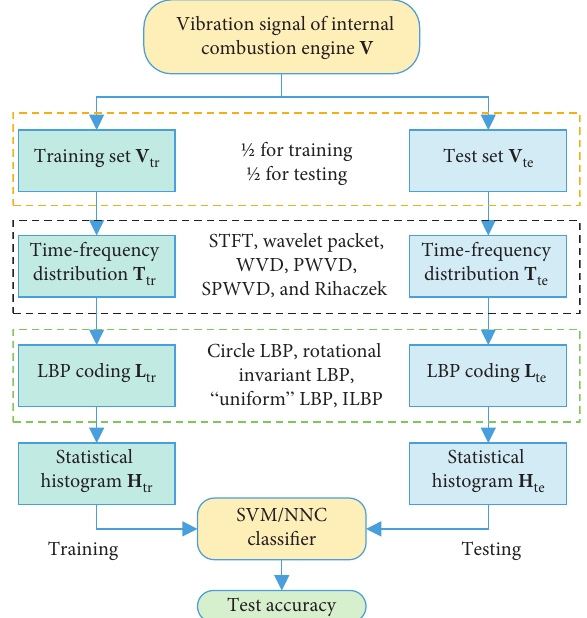
Figure 5: Experimental flowchart for fault diagnosis process of the diesel engine based on